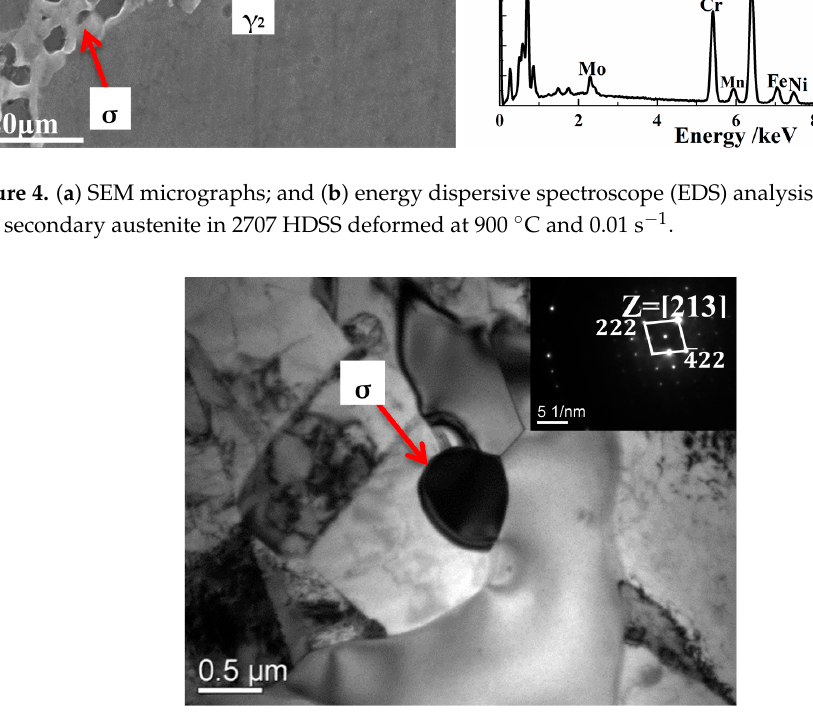
Figure 5. TEM micrograph and selected area electron diffraction (SAED) of σ in 2707 HDSS deformed at 900 °C and 0.01 s − 1 .